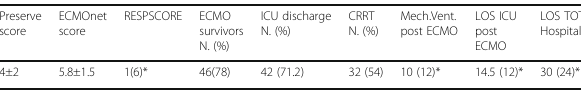
Table 35 (abstract A83). Predictive score and